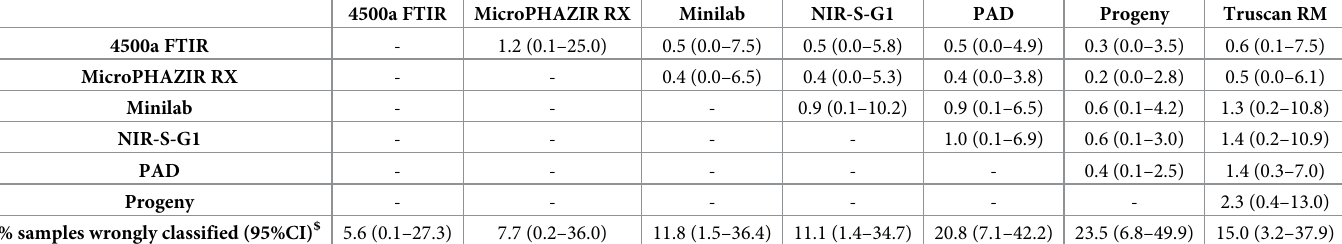
Table 6. Matrix of pairwise comparisons of accuracy of devices in classifying samples incorrectly during sample set inspections (test device in row vs reference device in column).